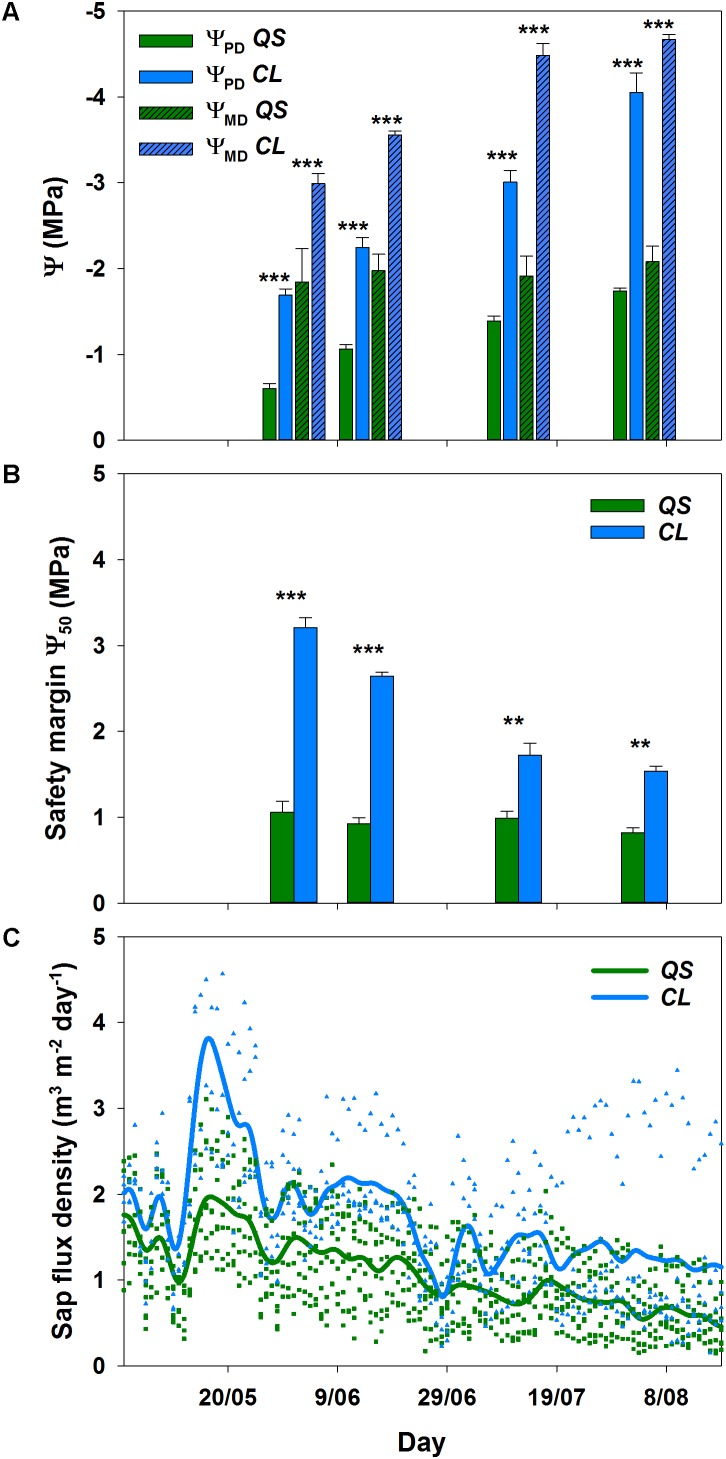
Pre-dawn (ΨPD) and midday leaf water potential (ΨMD) for Quercus suber (QS, n = 9) and Cistus ladanifer (CL, n = 7) with standard error (A). Safety margins (B) were calculated according to Choat et al. (2012). Sap flux density for Q. suber (QS, n = 7) and C. ladanifer (CL, n = 4) was fitted as non-parametric kernel-regression (C). Symbols are the values measured for each individual. Statistical differences (RMANOVA) between species are indicated by asterisks over bars at a significance level of ∗p < 0.05, ∗∗p < 0.01, ∗∗∗p < 0.001.